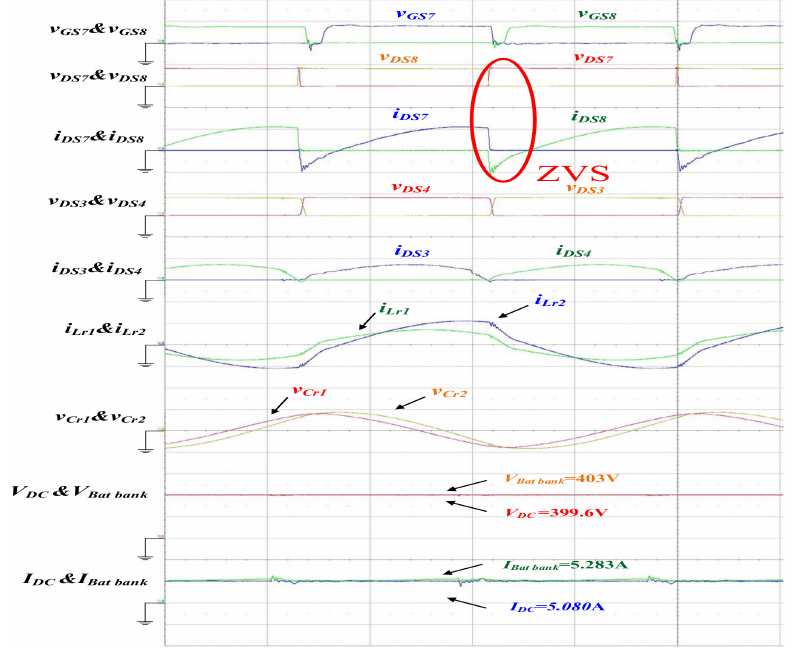
Figure 20. Waveforms obtained when the input battery voltage, V Bat bank , was 403 V and the fabricated converter was operated at full load ( v GS 7&8 : 20 V/div; v Cr 1&2 , V DC , V Bat bank : 200 V/div; v DS 7& , v DS 3&4 : 500 V/div; i DS 7&8 , i Lr 1&2 , i DS 3&4 : 10 A/div; I Bat bank , I DC : 5